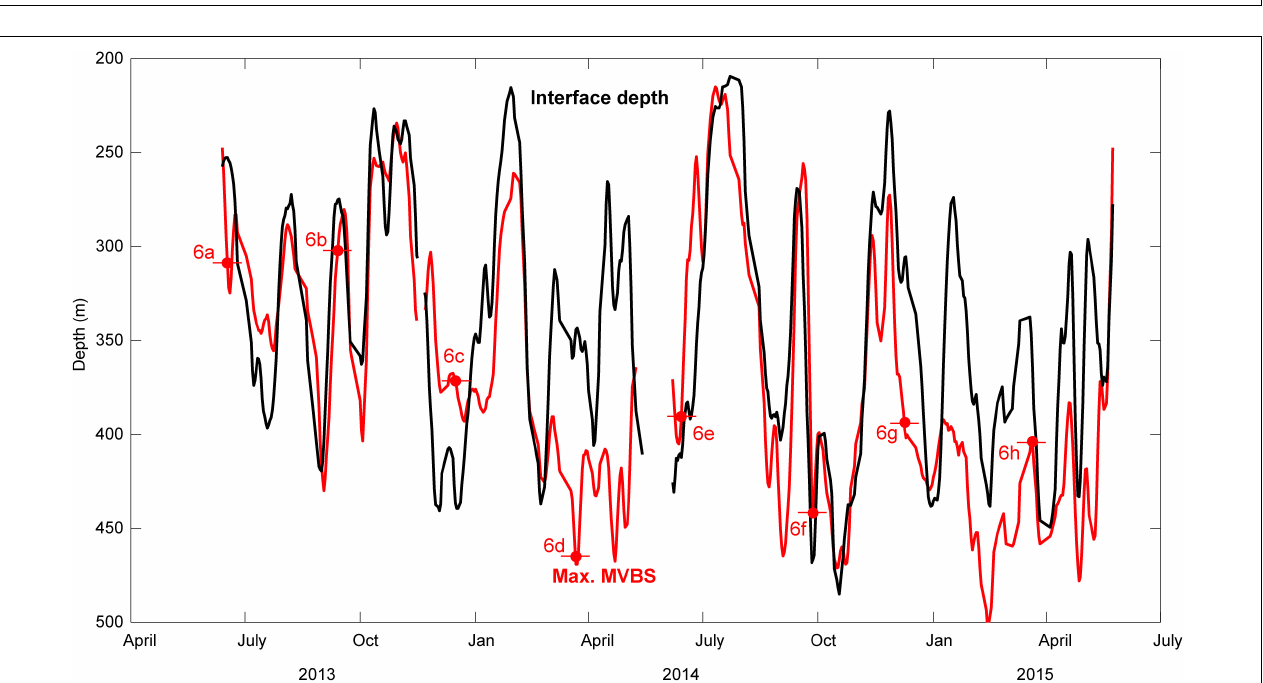
FIGURE 3 | Temporal variability of the depth of the interface (black) and the strongest mean volume backscattering strength MVBS (red) based on the ADCP deployments near the core of the Faroe Current jet. A 5 days low-pass filter has been applied to the daily averaged data. The red strikethrough dots and the associated labels refer to the days, illustrated in the corresponding panels in Figure 6